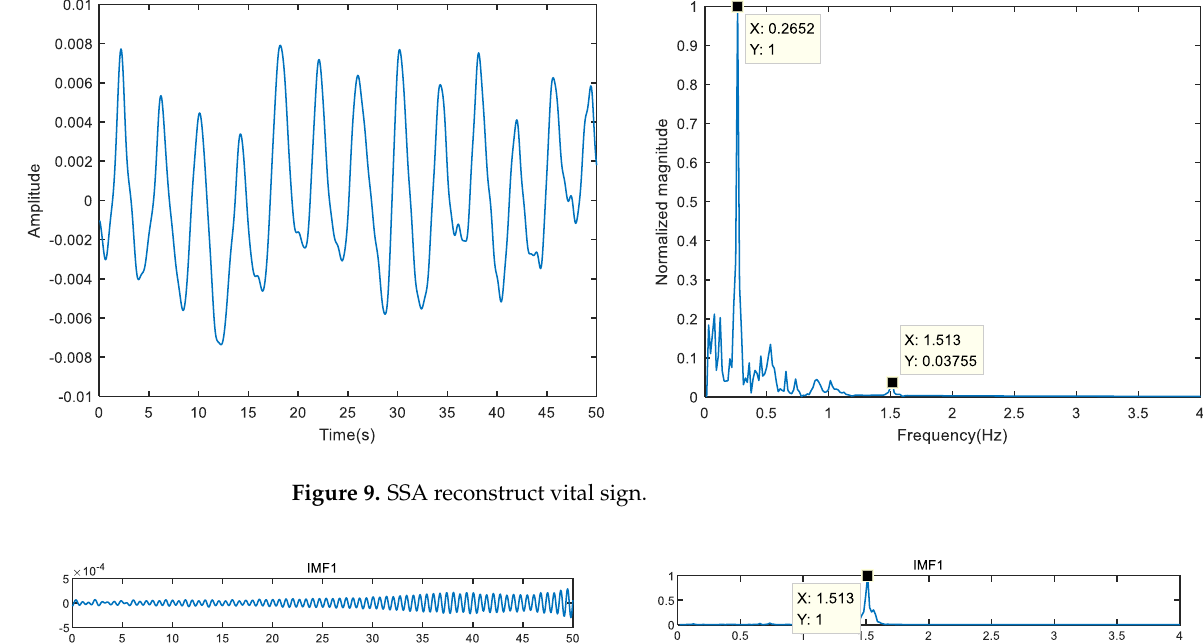
Figure 8. Singular value spectrum of trajectory matrix.